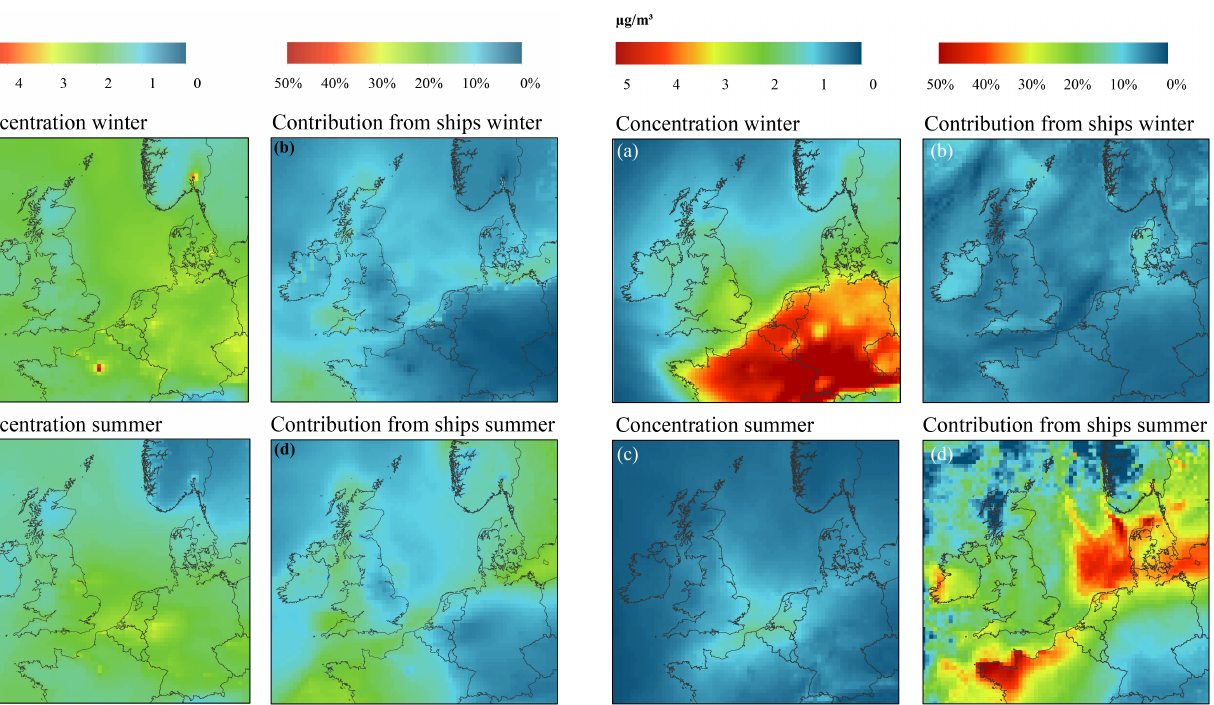
Figure 10. SO 2 − in summer and winter and the relative contribu- 4 tion of ship emissions.